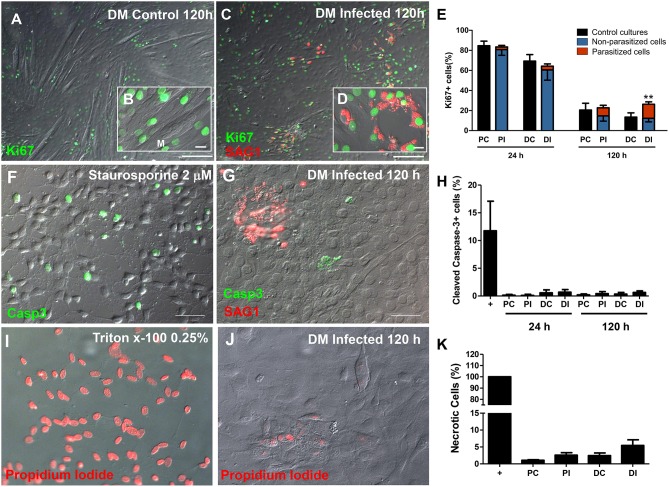
The C2C12 proliferation rate was altered by infection. Ki67 immunostaining was used as parameter to determine the number of mitotic cells. Micrographs depict Ki67 staining of cultures in DM after 120 h of induction in uninfected (A,B) and T. gondii-infected dishes (C,D). 24 h after treatment with DM no changes were detected (E). T. gondii increased the proliferation of DM-treated cultures, when compared to uninfected dishes (E). No Ki67 staining was observed in myotubes (M, in B), whereas cells harboring tachyzoites (shown in more detail in D) displayed intense nuclear immunolabeling. Cell death was assessed by staining for cleaved caspase-3 for apoptosis (F–H) and by propidium iodide uptake experiments for necrosis (I–K). T. gondii infection did not induce apoptotic cell death, since caspase-3 stained cells ranged from 0.1 to 0.7% in all experimental conditions (H). Treatment with Staurosporine 2 μM in DMEM high glucose with no serum for 2 h was used as a positive control (F). Tachyzoites were detected with anti-SAG1 antibody and displayed no correlation to the presence of caspase-3-stained cells (G,H). Necrosis was calculated by the percentage of PI-stained nuclei. Triton x-100 0.25% was used as positive control (I) and led to 100% of stained cells (K). Infected C2C12 cells at 120 h of myogenesis induction (J) displayed no significant difference when compared to uninfected cultures, both in PM or DM. N = 4, **p < 0.01, Two-Way ANOVA with Bonferroni post-test. Scale bars: 100 μm in (B,D), 20 μm in (C,E).